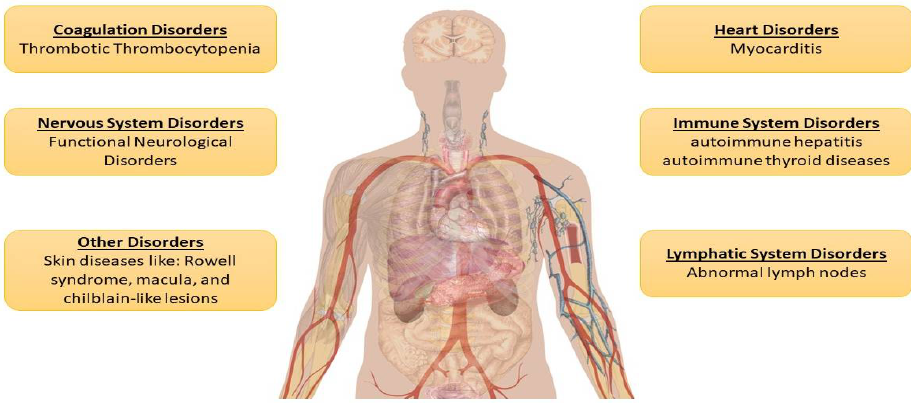
Figure 4. Possible COVID-19 vaccine complications. The following complications have been poten- tially associated with COVID-19 vaccines: (1) coagulation disorders (thrombocytopenia); (2) heart diseases (myocarditis); (3) lymphatic system diseases; (4) immune diseases (allergic reactions, auto- immune hepatitis, and thyroid diseases); (5) nervous system disorders (functional neurological dis- orders); and (6) other diseases (Rowell’s syndrome, macular rash, and chilblain-like lesions)].